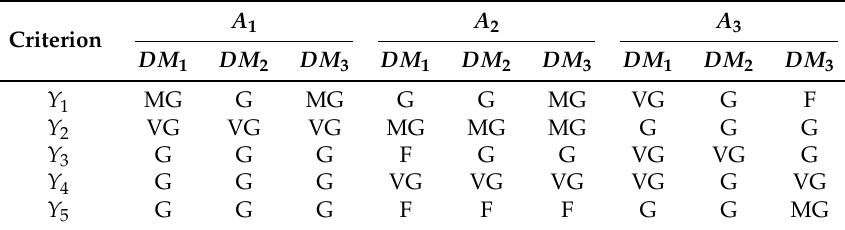
Table 4. Alternatives ratings by decision-makers.